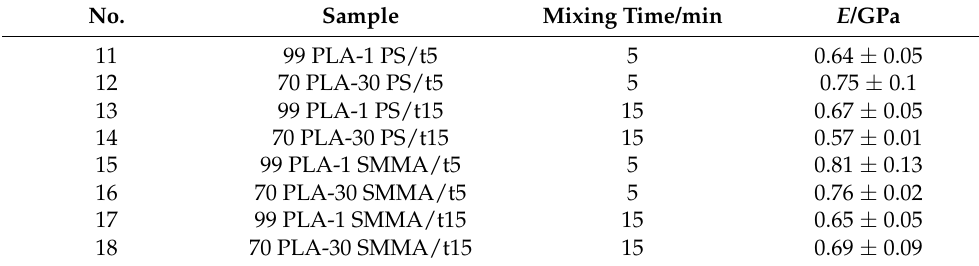
Table 3. Summarizes the elastic modulus ( E ) results for PS-PLA and SMMA-PLA under a mixing time of 5 and 15 min.